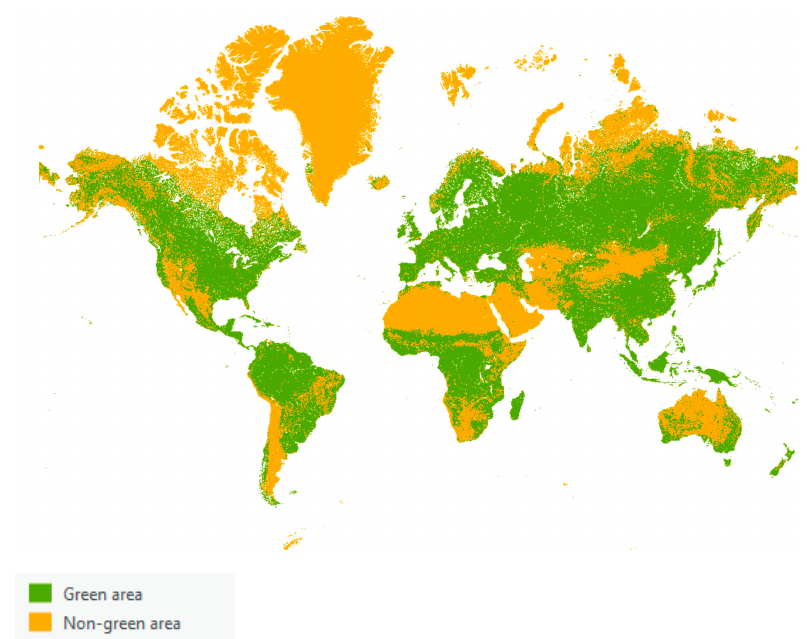
Figure A1. Green/non-green cover map obtained from reclassification of ESA CCI-LC 2015.